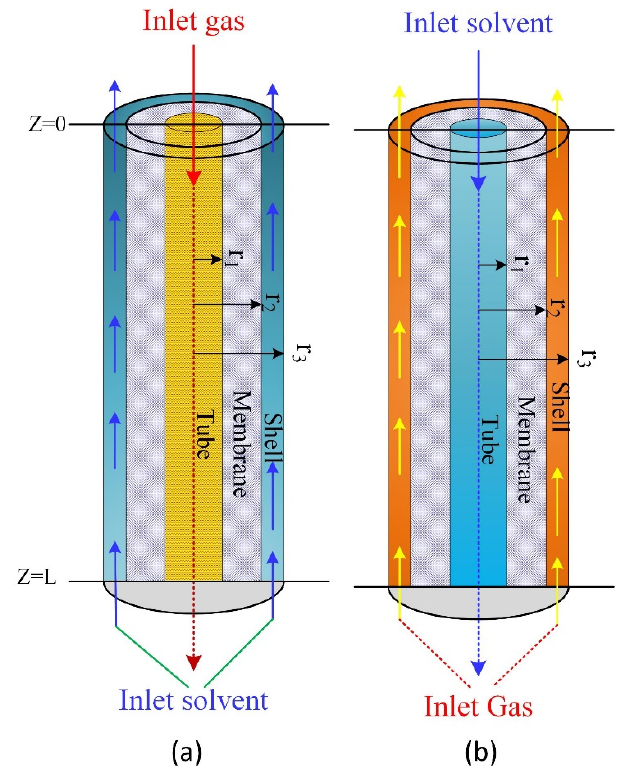
Figure 1. Schematic diagram and the membrane contactor model domain: ( a ) gas fed in the lumen side, ( b ) gas fed in the shell side.